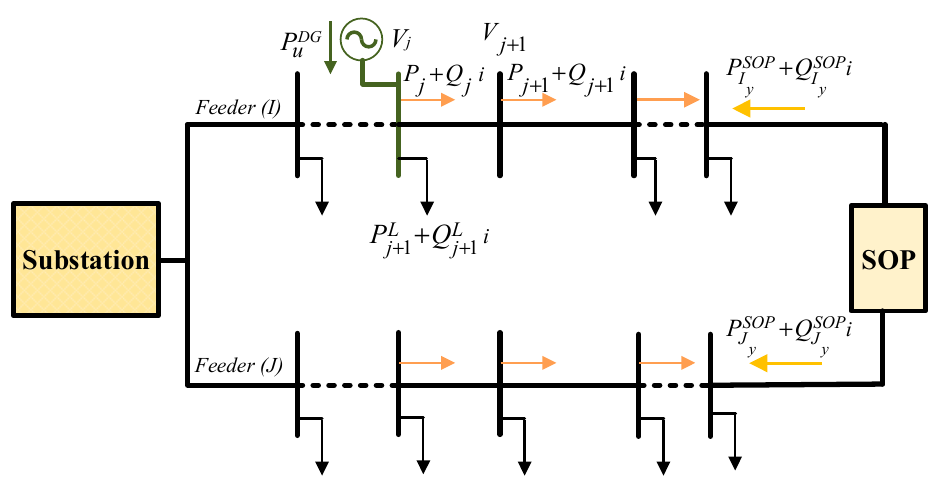
Figure 1. Distribution system modeling.